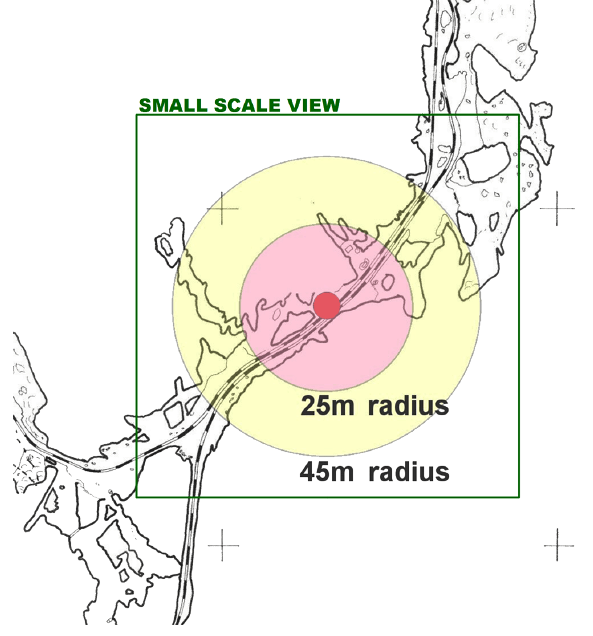
Fig. 4. Indication of WiFi coverage area of the monitoring station during the drive-by test in Postojna Cave (red dot is cave monitor- ing station; yellow circle (45m radius) shows area where a WiFi connection to the station could be made as measured using note- book computer, with static measurements along the main path of the tourist railway, which slows down at this point).